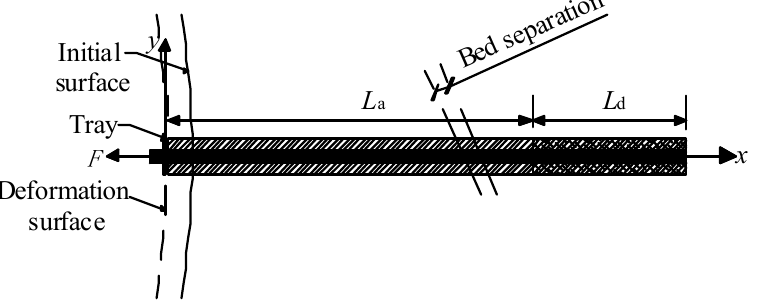
Figure 1. Basic constitution of the full-grouted prestressed bolt.